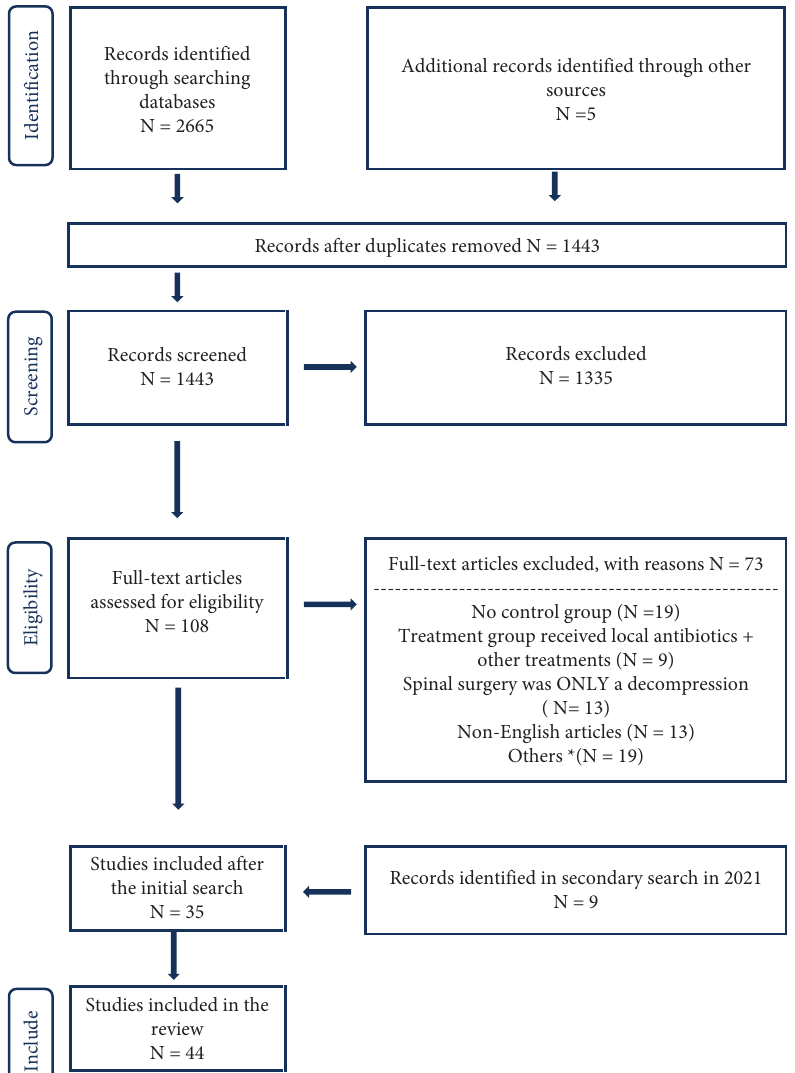
Figure 1: Literature search flowchart for Preferred Reporting Items for Systematic Reviews and Meta-Analyses (PRISMA). ∗ Excluded for the following reasons: no patient data, pediatric study, no local antibiotic usage, repeat study, animal study, not accessible, and includes surgeries that are not instrumented spinal fusion or fracture surgeries.